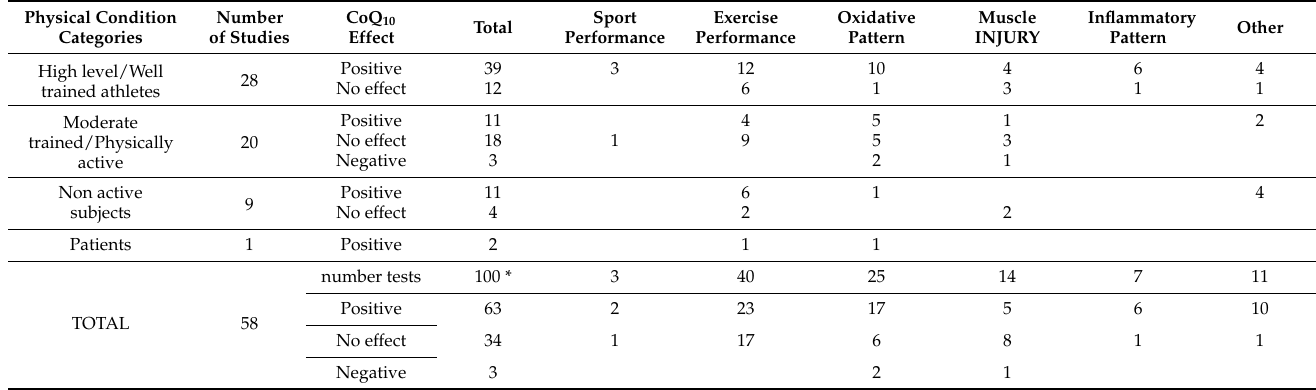
Table 10. Results of the Ubiquinone and Ubiquinol supplementation on different sport and exercise variables depending on the physical condition of the subjects evaluated.